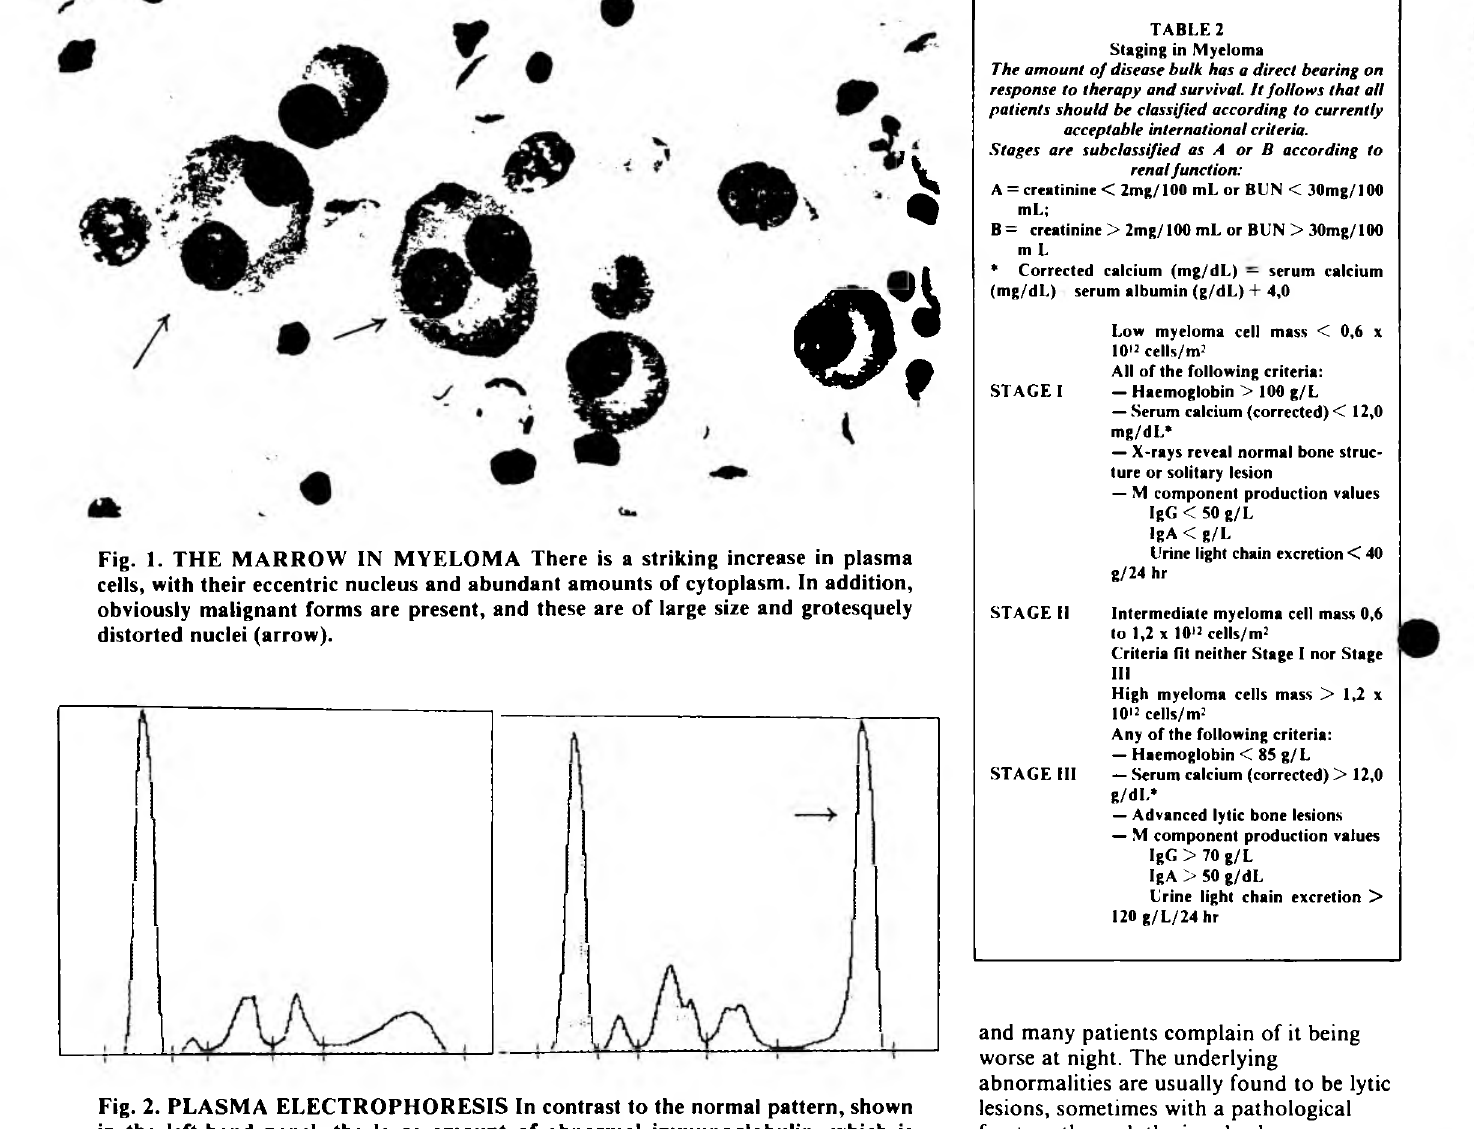
Fig. 2. PLASMA ELECTROPHORESIS In contrast to the normal pattern, shown in the left-hand panel, the large amount of abnormal immunoglobulin, which is known as paraprotein, is strikingly evident in the right-hand panel (arrow).